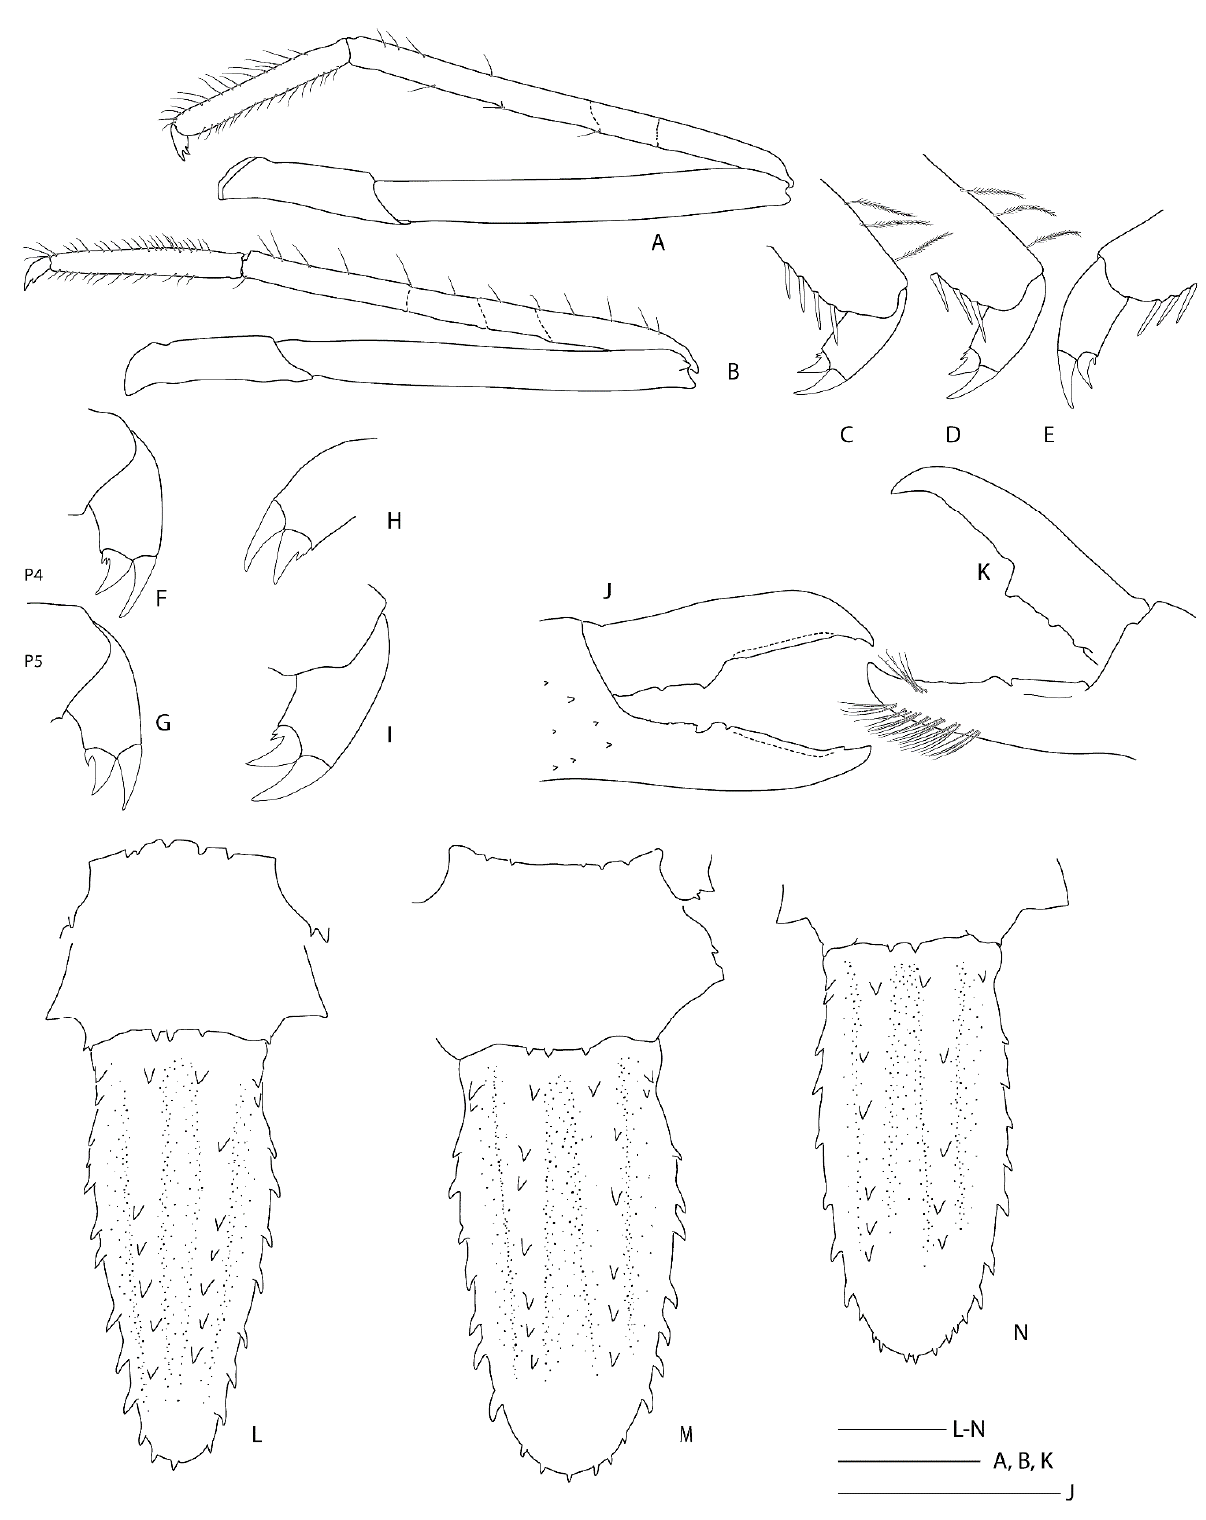
Figure 21. Spongiocaris antipodes sp. nov., ( A – E ): paratype F, PCL 8.0 mm (NIWA 127133); ( F , G ): F ov., PCL 7.9 mm (NMNZ CR.019259); H , I : lose appendages, unknown origin (NMNZ CR.019491); ( J ): M, PCL 4.6 mm (NIWA 135621); ( K , N ): M, PCL 7.3 mm (NMNZ CR.019494); ( L ): M, PCL 7.5 mm (NMNZ CR.019491); ( M ): F ov., PCL 8.0 mm (NMNZ CR.019491). ( A , B ) lose right P4 and P5. ( C , D ) Dactylus and distal propodus, lose right P4 and P5. ( E ) dactylus and propodus, presumed left P4. ( F – I ) Dactylus and distal propodus, P4 and P5. ( J , K ) fingers and distal palm, P3, outside view. ( L – N ) telson and pleonite 6, dorsal. Scale bars = 2 mm.